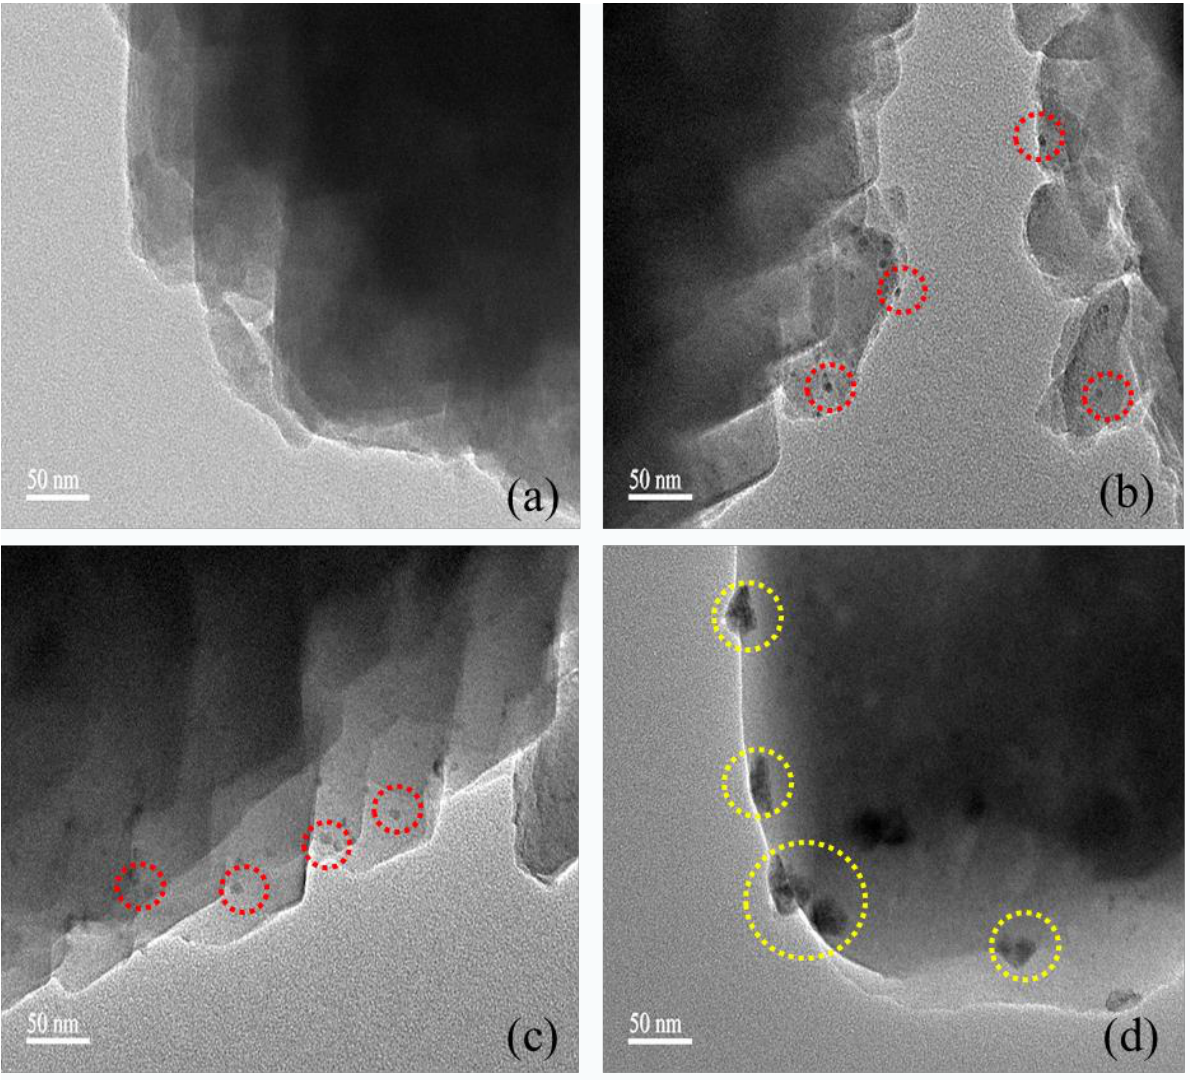
Figure 3. TEM images of the ( a ) Pd/SSZ-13 and K-deactivated samples ( b ) 0.5K-Pd/SSZ-13, ( c ) 1.0K- Pd/SSZ-13 and ( d ) 1.5K-Pd/SSZ-13. The red and yellow circle represents aggregated Pd clusters.